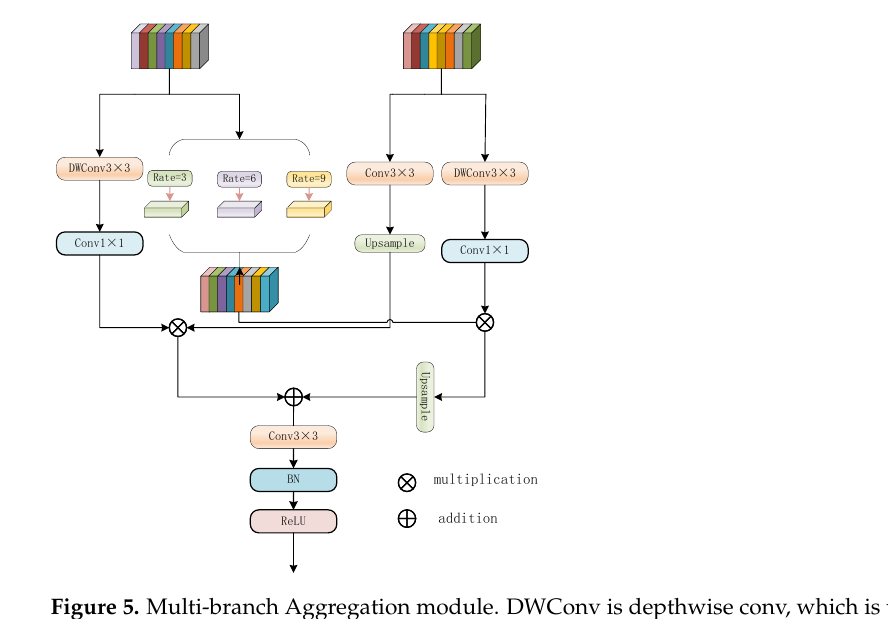
Figure 5. Multi-branch Aggregation module. DWConv is depthwise conv, which is used to reduce calculation parameters. Rate stands for void